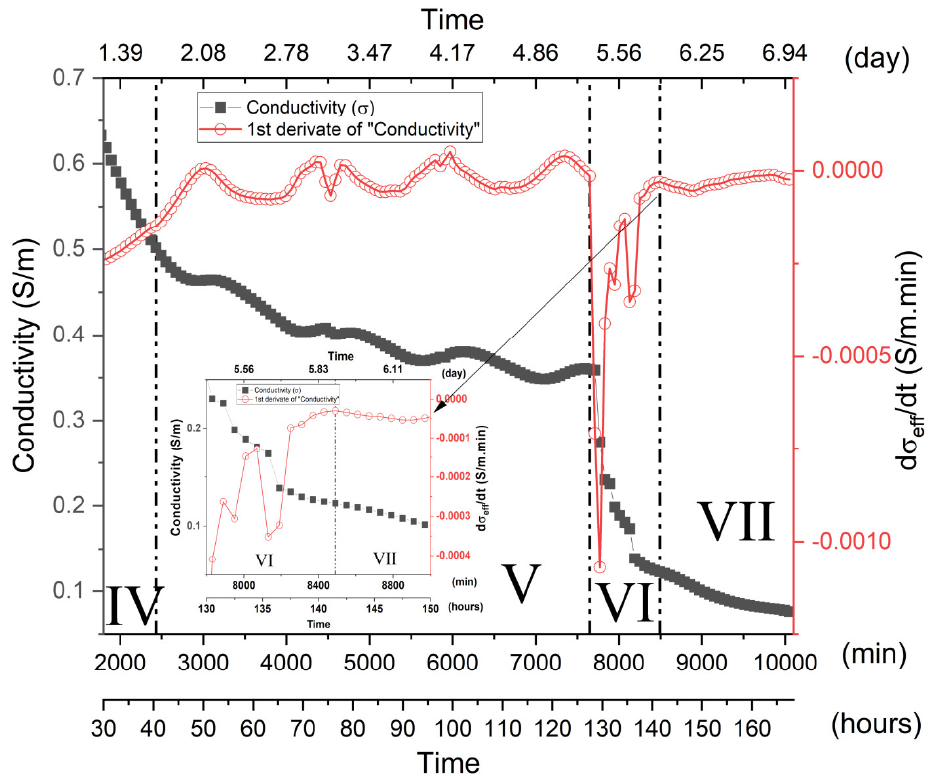
Figure 9. Effective electrical conductivity, σ eff , and its derivative, dσ eff /dt, as a function of the geopolymerization time, highlighting regions IV–VI (for MK1). Inset illustrates the inflection points of the dσ eff /dt curve adopted as a delimiter between stages VI and VII.